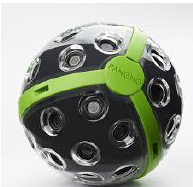
Figure 8. Panono Camera (www.panono.com)